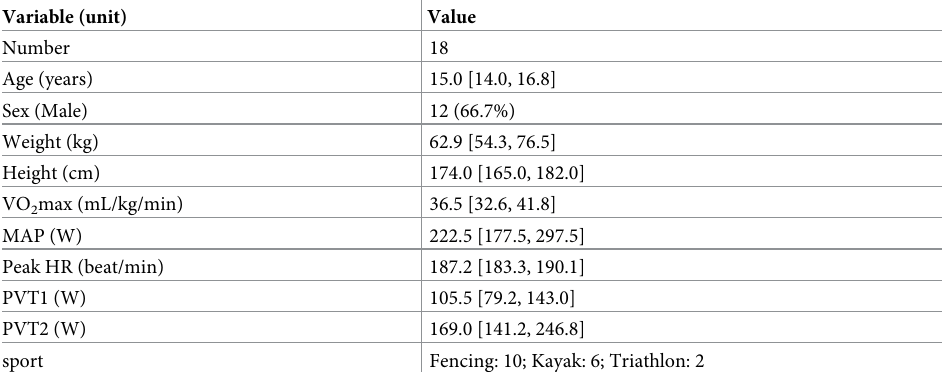
Table 1. Physiological characteristic of the 18 participants. Values indicated are medians [Inter quartile range].